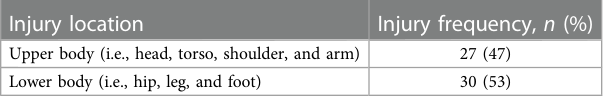
TABLE 6 Location a and frequency of sport-related injuries observed during the competitive season.